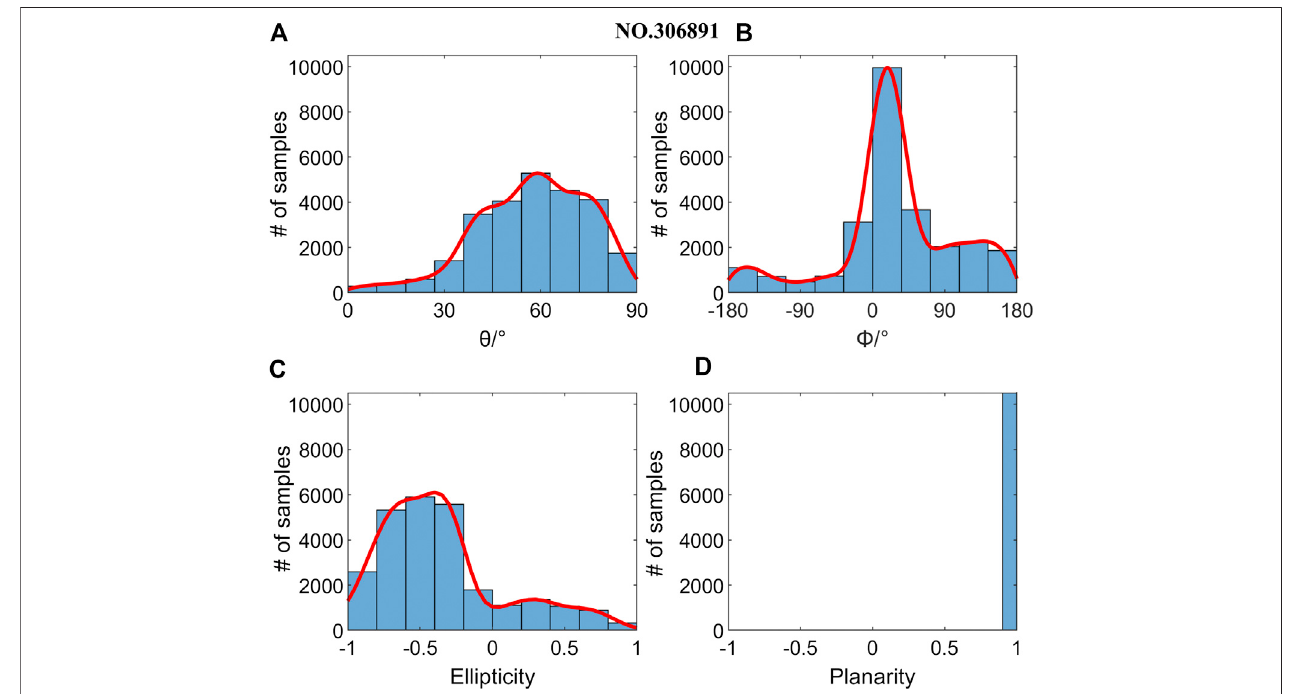
FIGURE8| Distribution ofwavepropagationparametersforthewavesinextremelylowfrequency(300 – 800 Hz)inthearea(7.4 ° – 3.8 ° S,106.1 ° – 105.6 ° E)recorded by No. 306891 at ∼ 14:44 to 14:45 UT, marked by the black square in Figure 7 . The overlapped red lines represent fi tted curves computed by a probability density function; (A) wave normal angle θ ; (B) and azimuth angle ϕ of the wave vector; (C) the ellipticity; (D)